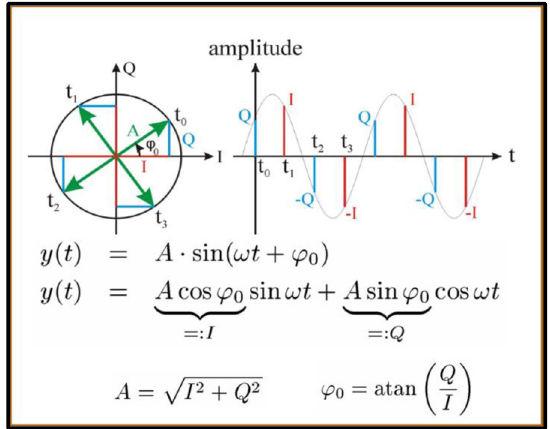
Figure 12. I-Q demodulation.